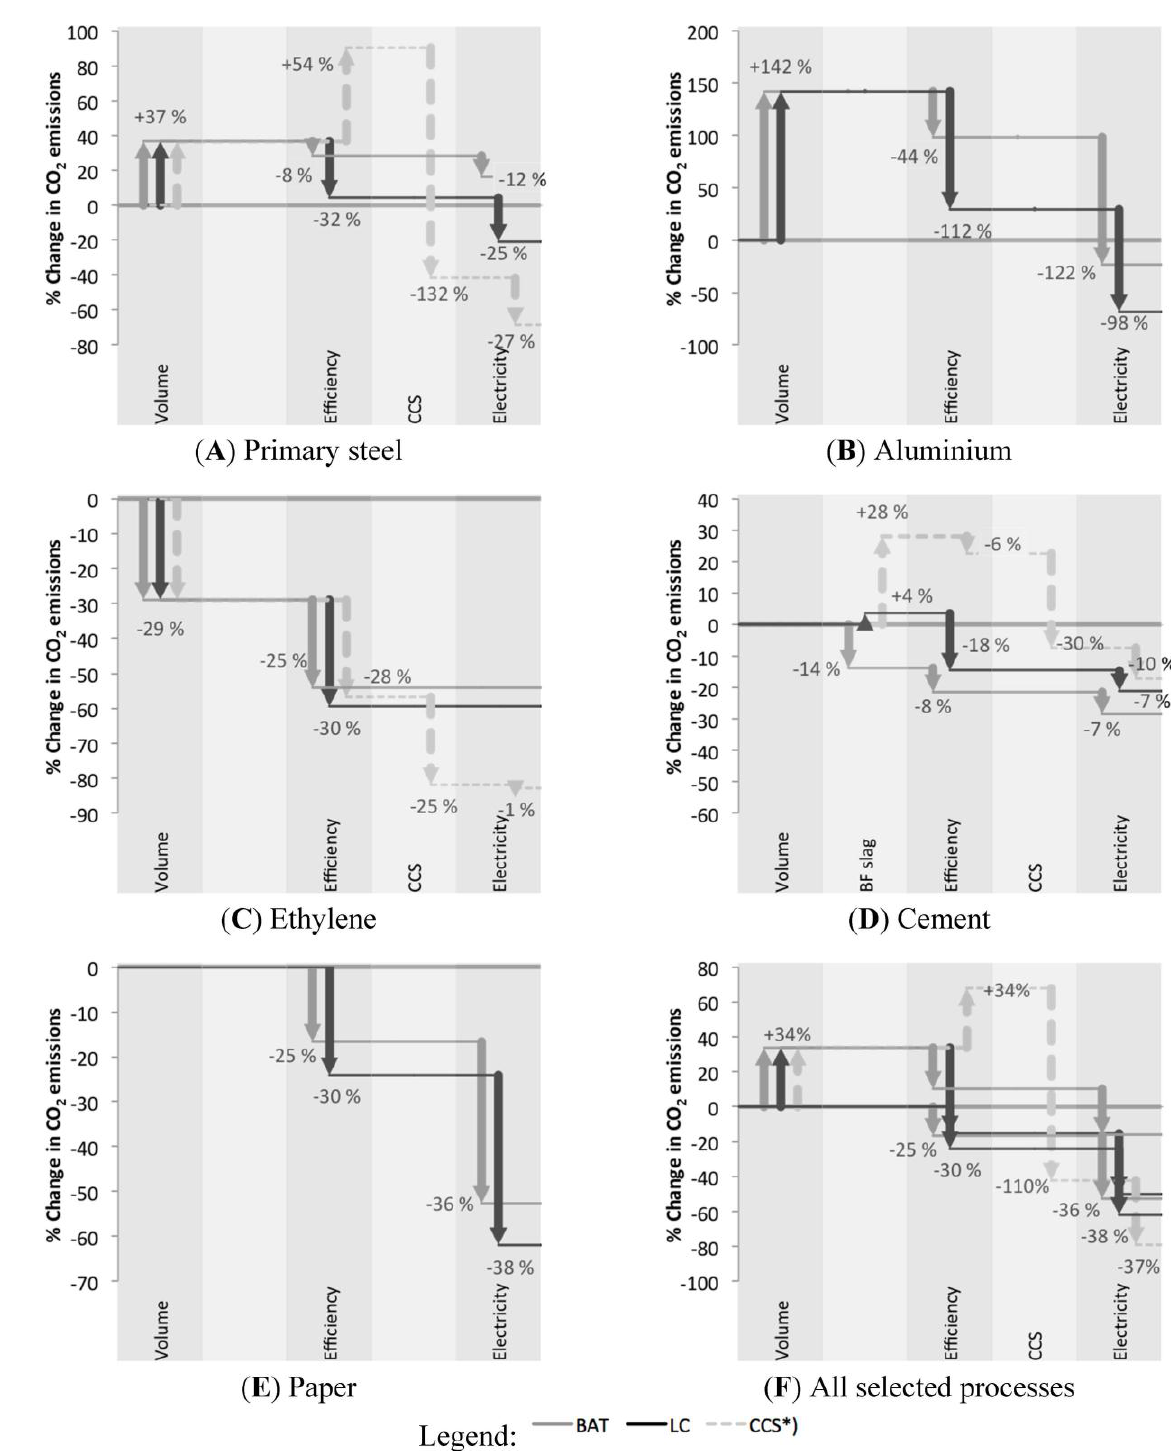
Figure 5. Percentage change in CO 2 emissions in 2050 in the three scenarios compared to 2010 levels in selected industrial production processes (panels A to E ) and overall for NRW (panel F ). *) CCS options were not considered in the aluminium or paper sectors. In these sectors, the assumptions of the LC scenario were applied to the CCS scenario. Legend: Volume—Volume effect; Efficiency—effect of energy efficiency and fuel switch; Electricity—effect of mitigation in the energy sector; BF slag—change in cement industry due to changes in steel